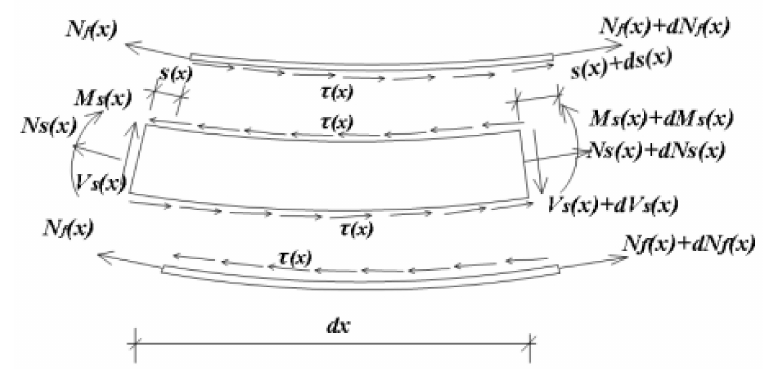
Figure 18. Micro-segment analysis